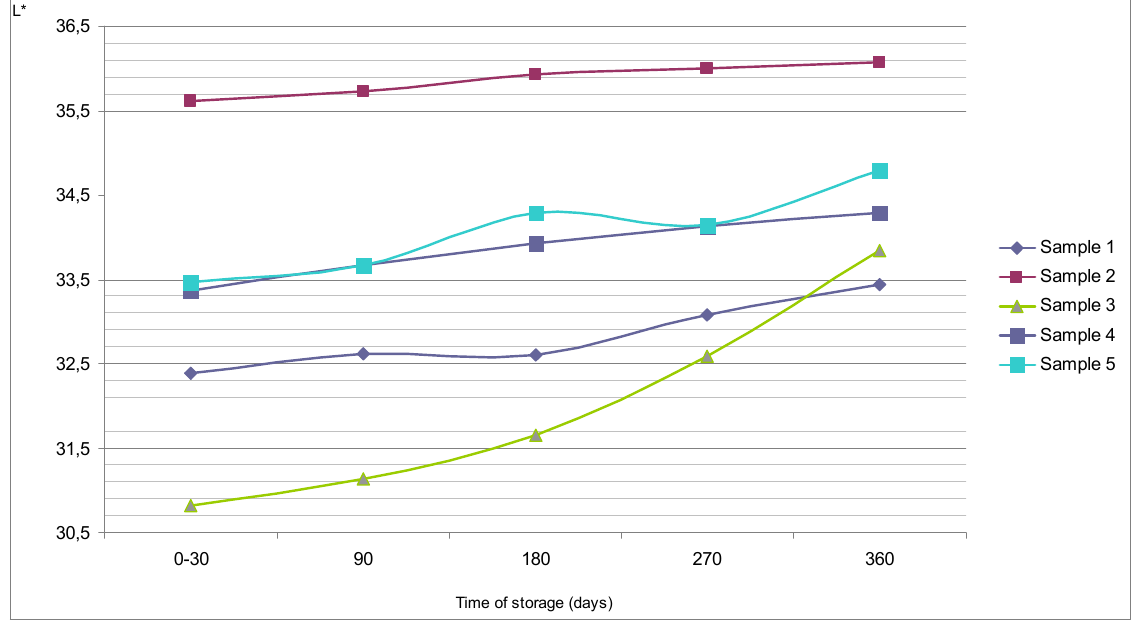
Figure 5. Changes of psychometric light (L*) on the bottom surface of samples of dietary chocolates during storage of 360